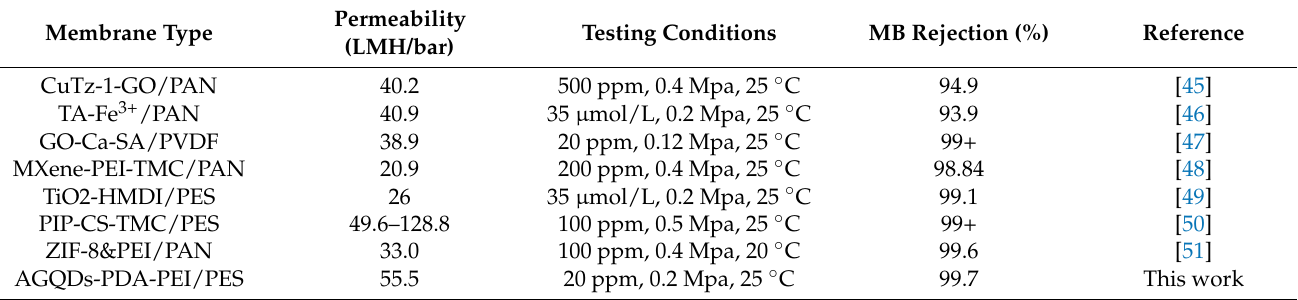
Figure 14. Photocatalytic degradation of MB by AGQDs and GQDs ( A ), UV-Visible spectrum of MB after irradiation ( B ). Table 4. Comparisons of water permeability and MB rejection between this study and